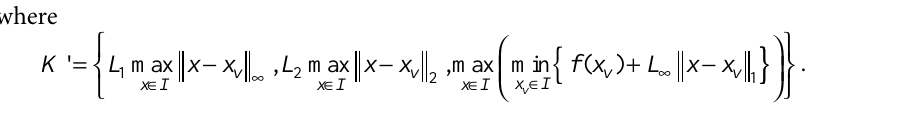
Algorithm 1. Branch-and-bound algorithm with combination of